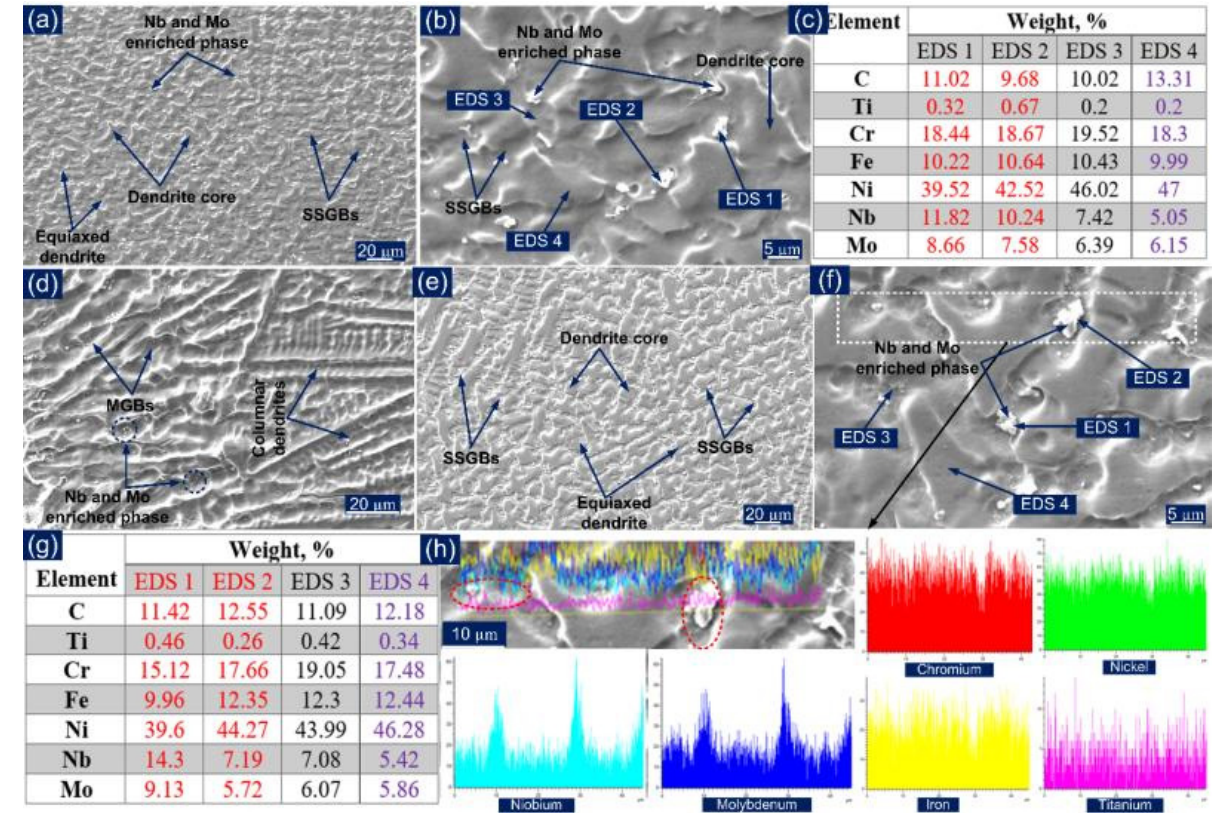
Figure 12. ( a ) AW joint: SE image of the weld metal showing the equiaxed dendritic microstructure, ( b ) marked EDS location, ( c ) EDS spectrum results; PWHT: ( d ) near interface showing columnar dendrites, ( e ) interior weld metal showing equiaxed dendrites, ( f ) marked EDS location, ( g ) EDS spectrum results; ( h ) line mapping across the inter-dendritic boundaries in the region of bulk weld metal.